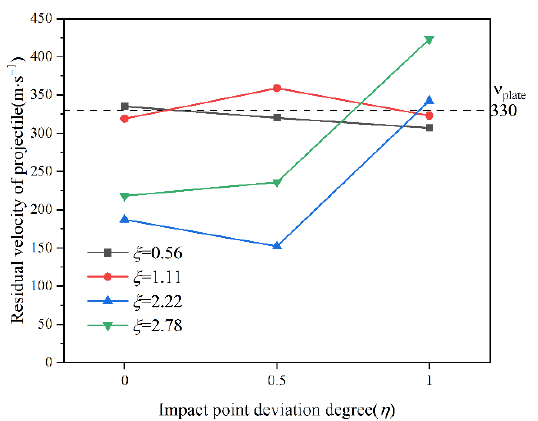
Figure 21. Comparison of residual velocities of the projectile when penetrating the ceramic composite armor with different ξ values when η = 0, 0.5, 1.